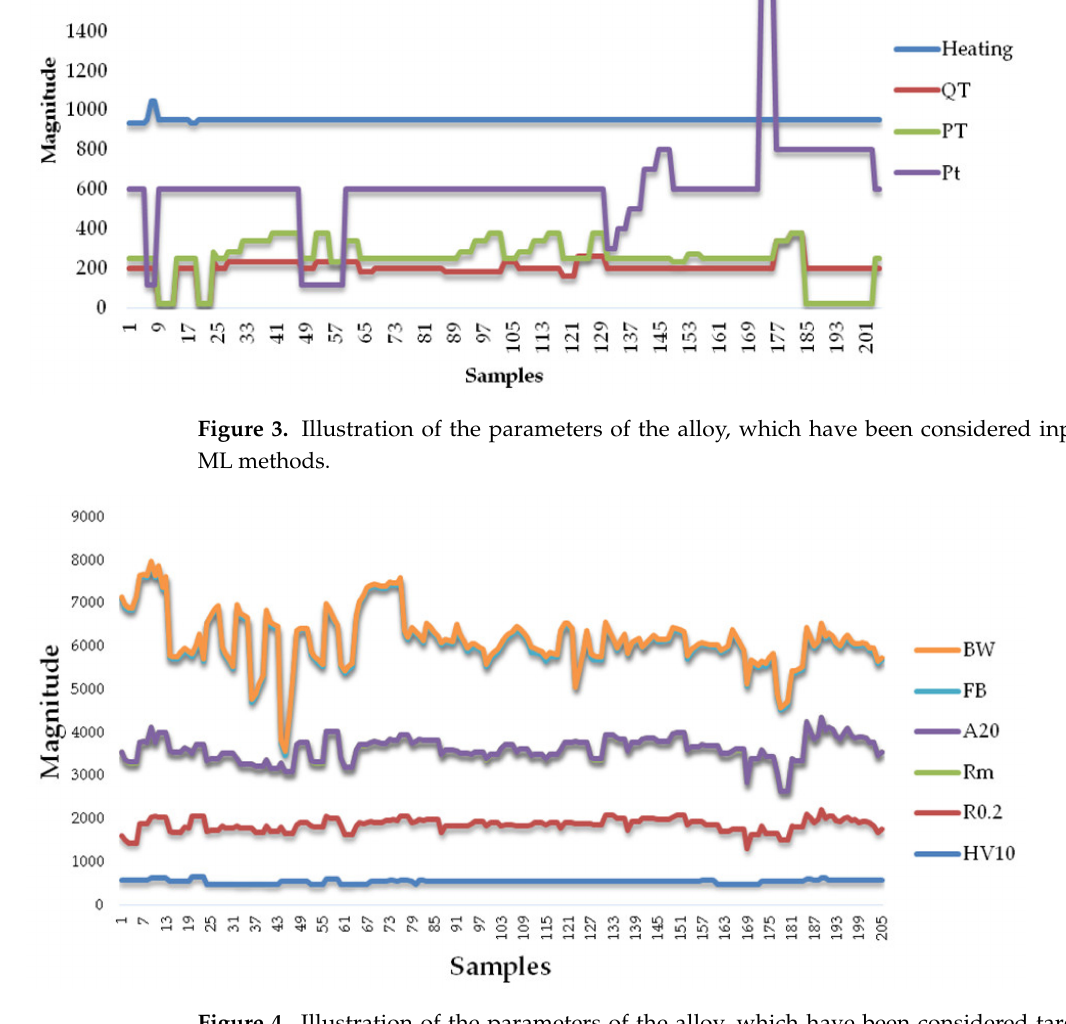
Figure 4. Illustration of the parameters of the alloy, which have been considered targets for the ML